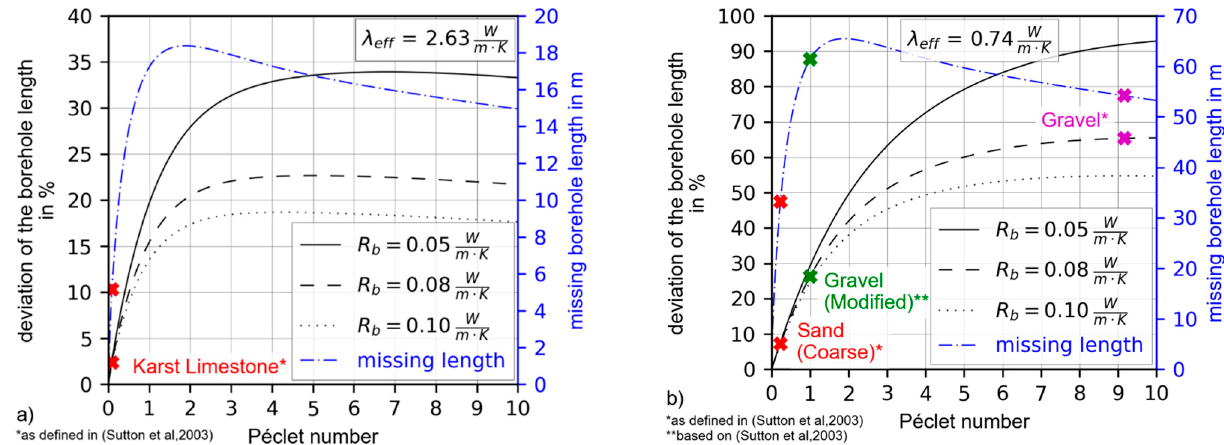
Figure 10. Deviation in borehole length depending on the Péclet number for the thermal properties as listed in Table 3 of ( a ) Karst Limestone and ( b ) Gravel and Sand (coarse).